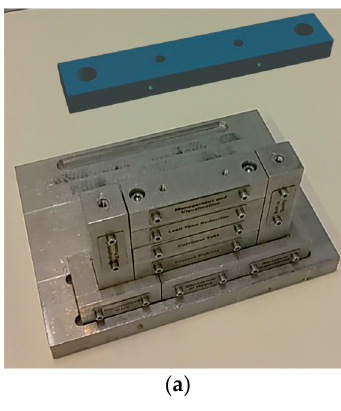
Figure 7. The animation for correctly positioning the banner: (a) the correct part moves from the component box and (b) with the animation positions itself on the assembly.